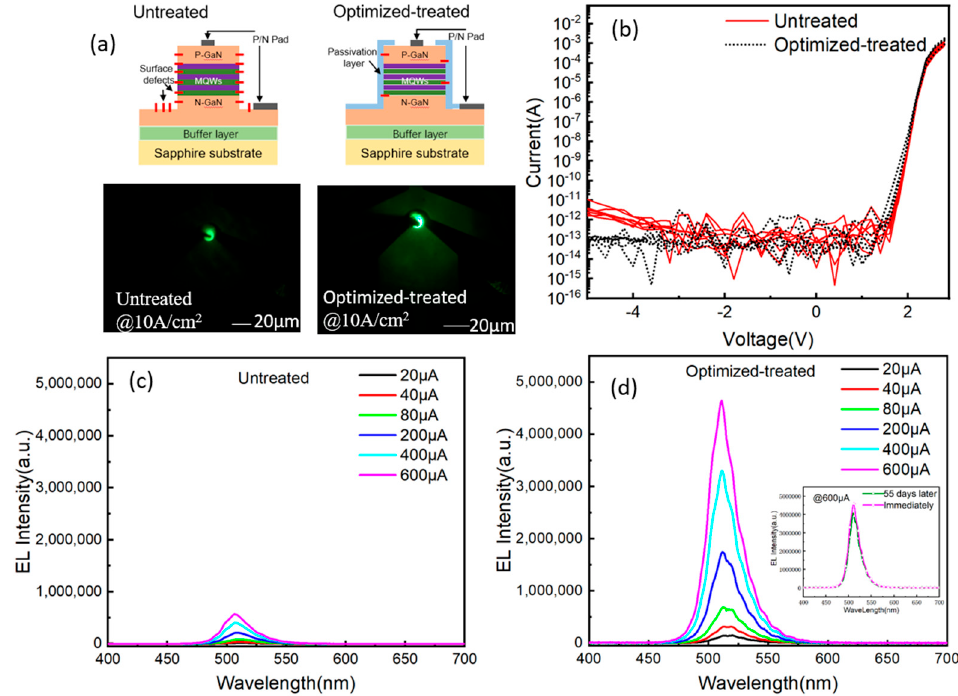
Figure 4. ( a ) Structural diagram and working images of Micro-LED devices; ( b ) Current-Voltage (I-V) curves before and after optimization; ( c ) EL spectra of untreated Micro-LED under the injected current of 600 μ A; ( d ) EL spectra of optimized-treated Micro-LED under the injected current of 600 μ A.